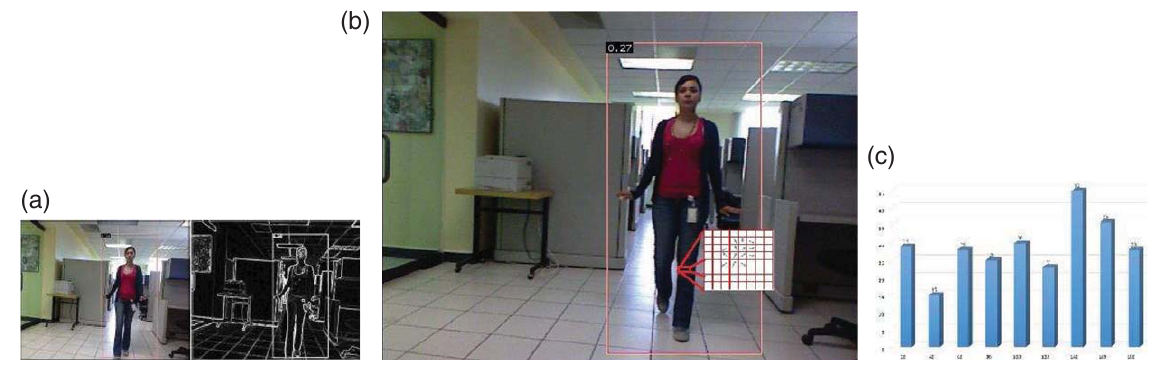
Fig. 9. HOG detection of a person: a) (left) image gradient in the zone of analyse; b) (middle) extraction of gradients; c) (right) computed histograms.